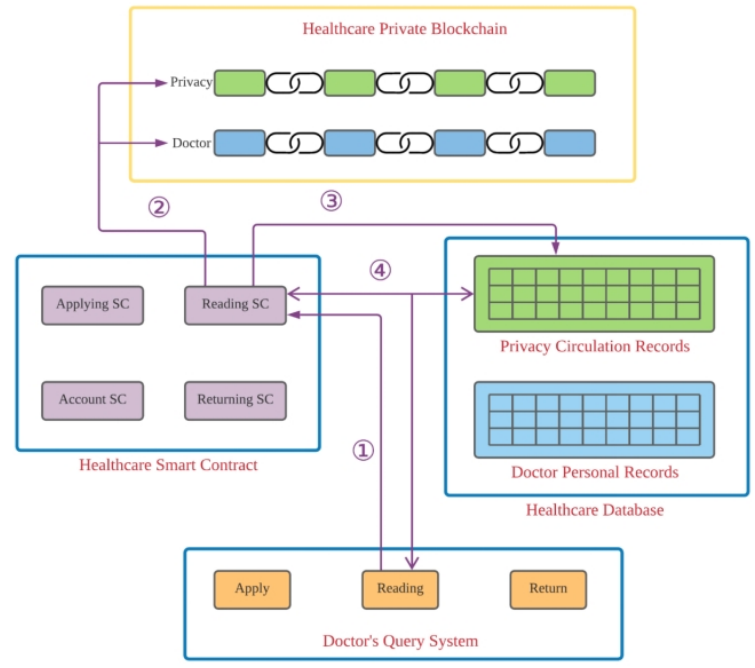
Figure 4. Proposed blockchain-based access control framework.